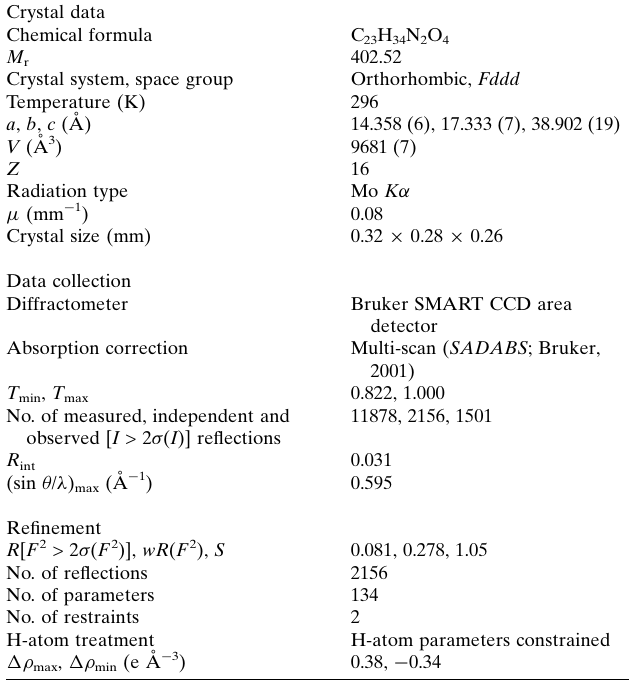
Table 2 Experimental details.